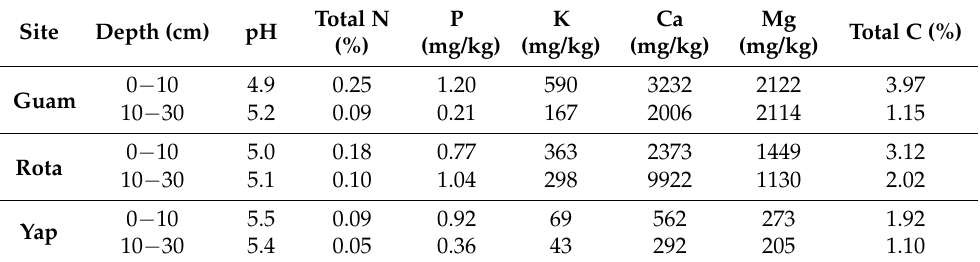
Table 3. Soil characteristics at each